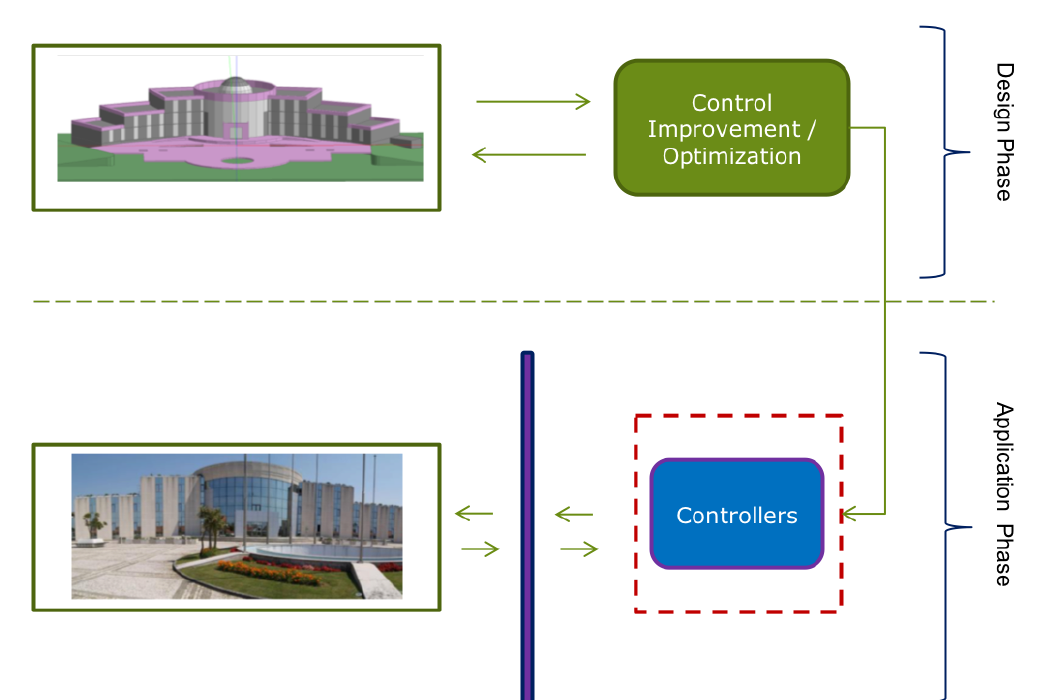
Figure 2. The simulation-based control improvement